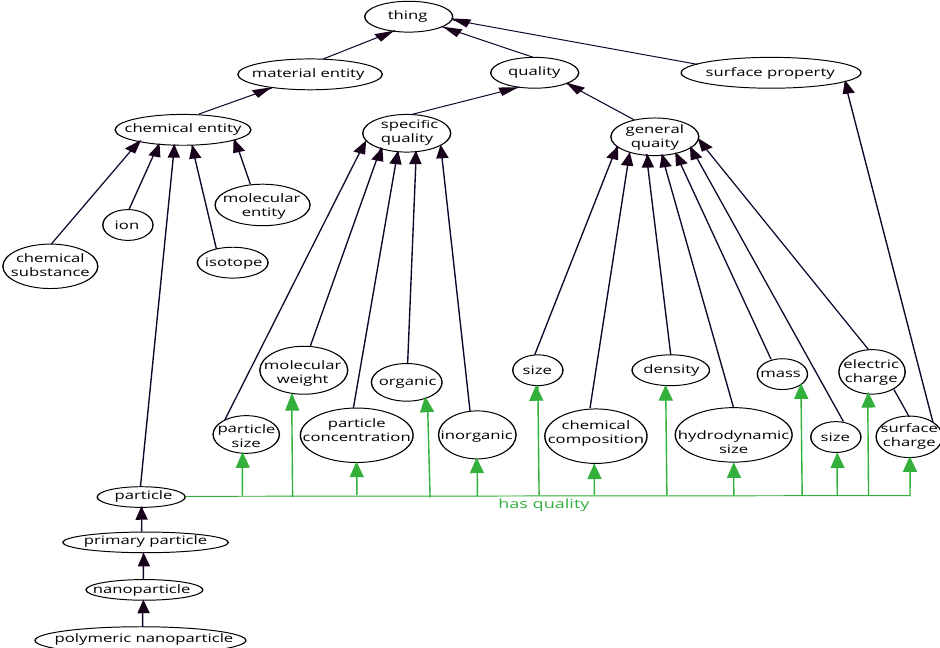
Figure 14. An ontology example: Sample of the NanoParticle ontology (Redrawn, based on [259]). Metadata modeling can be viewed as an intermediate component between